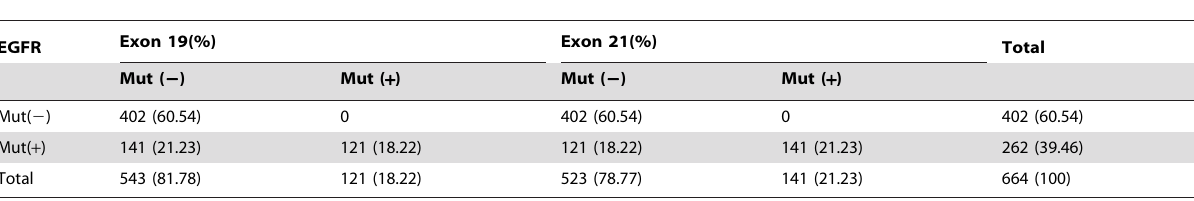
Table 2. EGFR mutation in lung adenocarcinomas.